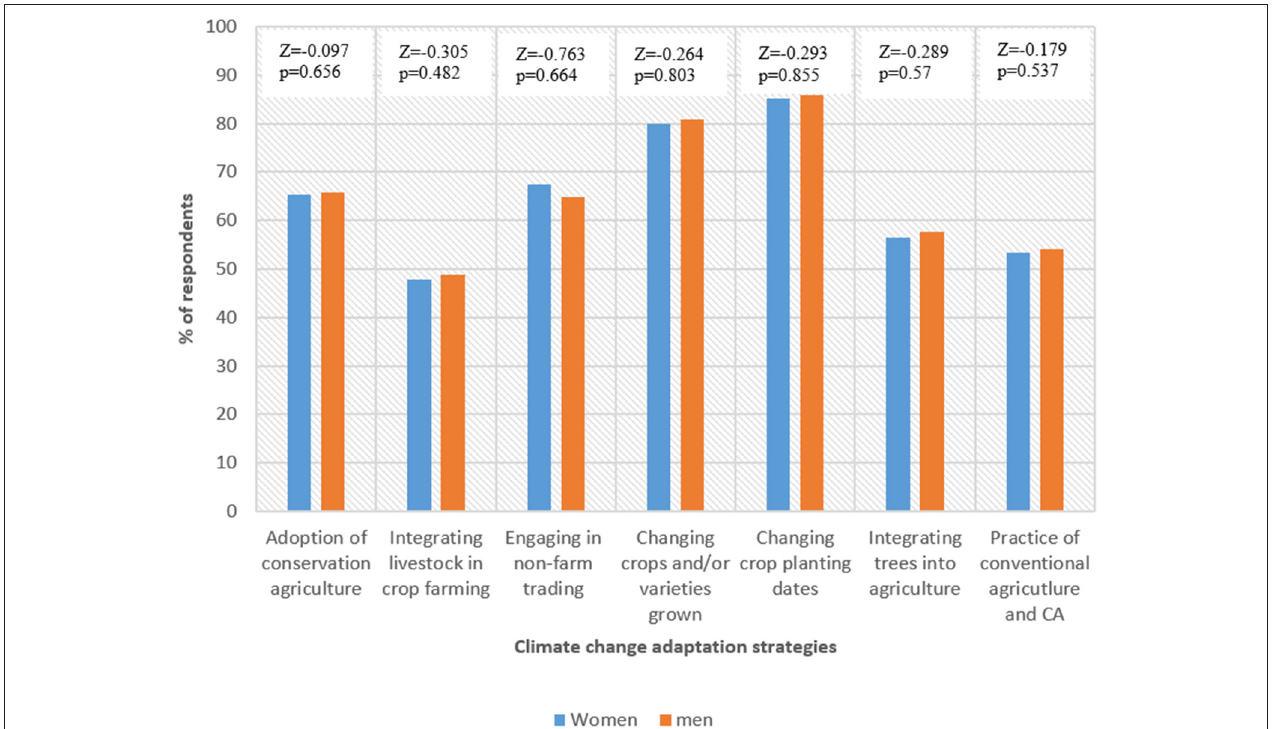
FIGURE 6 | Awareness of climate change adaptation strategies by men and women